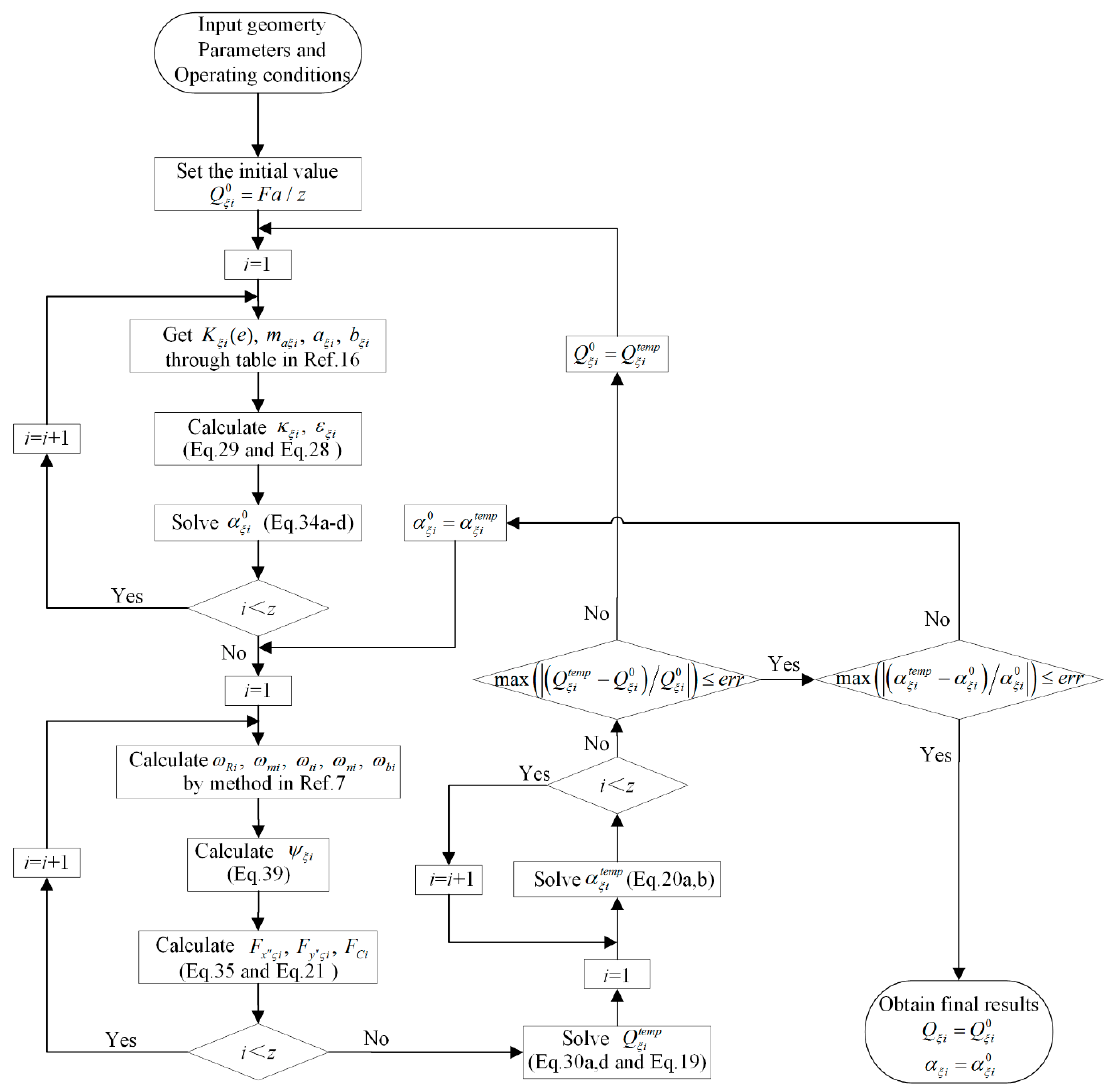
Figure 9. Numerical solution flow chart of normal contact force and contact angle.